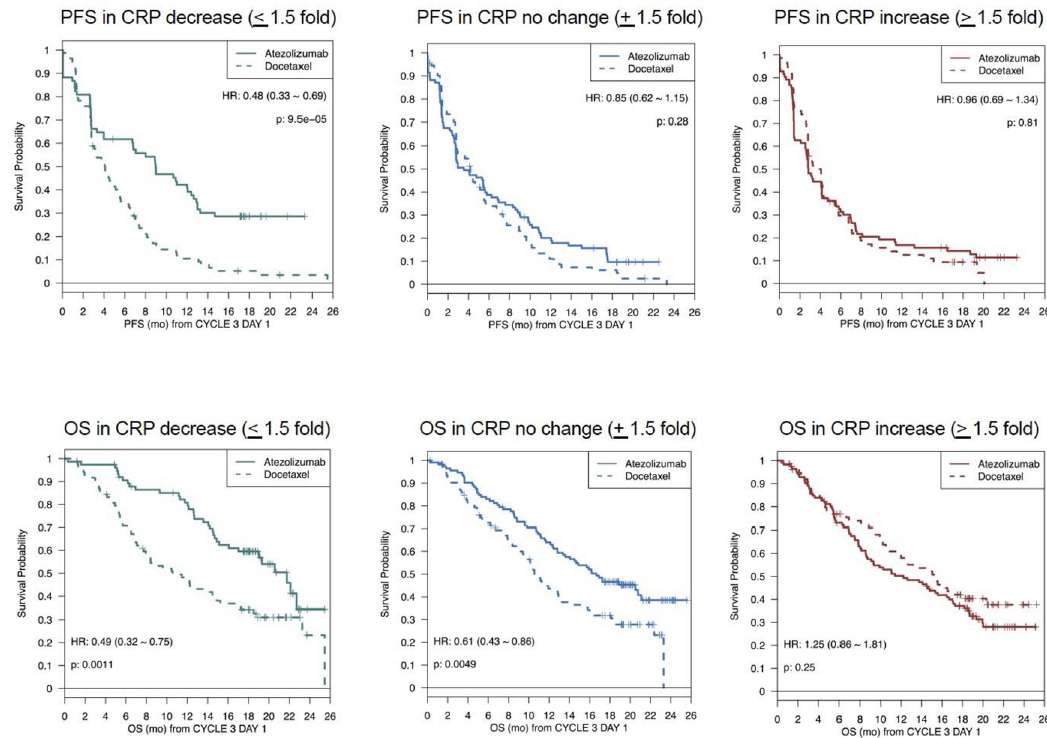
Fig 3. Landmark OS and PFS Kaplan-Meier curves for patients binned by CRP changes at 6 weeks. Landmark OS and PFS Kaplan-Meier curves were plotted based on patients binned by CRP fold changes at 6 weeks. (3a ) PFS (Top) and ( 3b ) OS (Bottom) were calculated from 6 weeks or cycle 3 day 1 (C3D1) post-treatment; patients censored or with an event before this time were excluded from this analysis. Patients treated with atezolizumab are in the solid lines and patients treated with docetaxel are in the broken lines. The first panel is patients who had CRP decrease (blue), the middle panel is patients who showed no change in CRP (black) and the last panel is patients who showed an increase in CRP (red). CRP, C-reactive protein; HR, hazard ratio; OS, overall survival; PFS, progression free